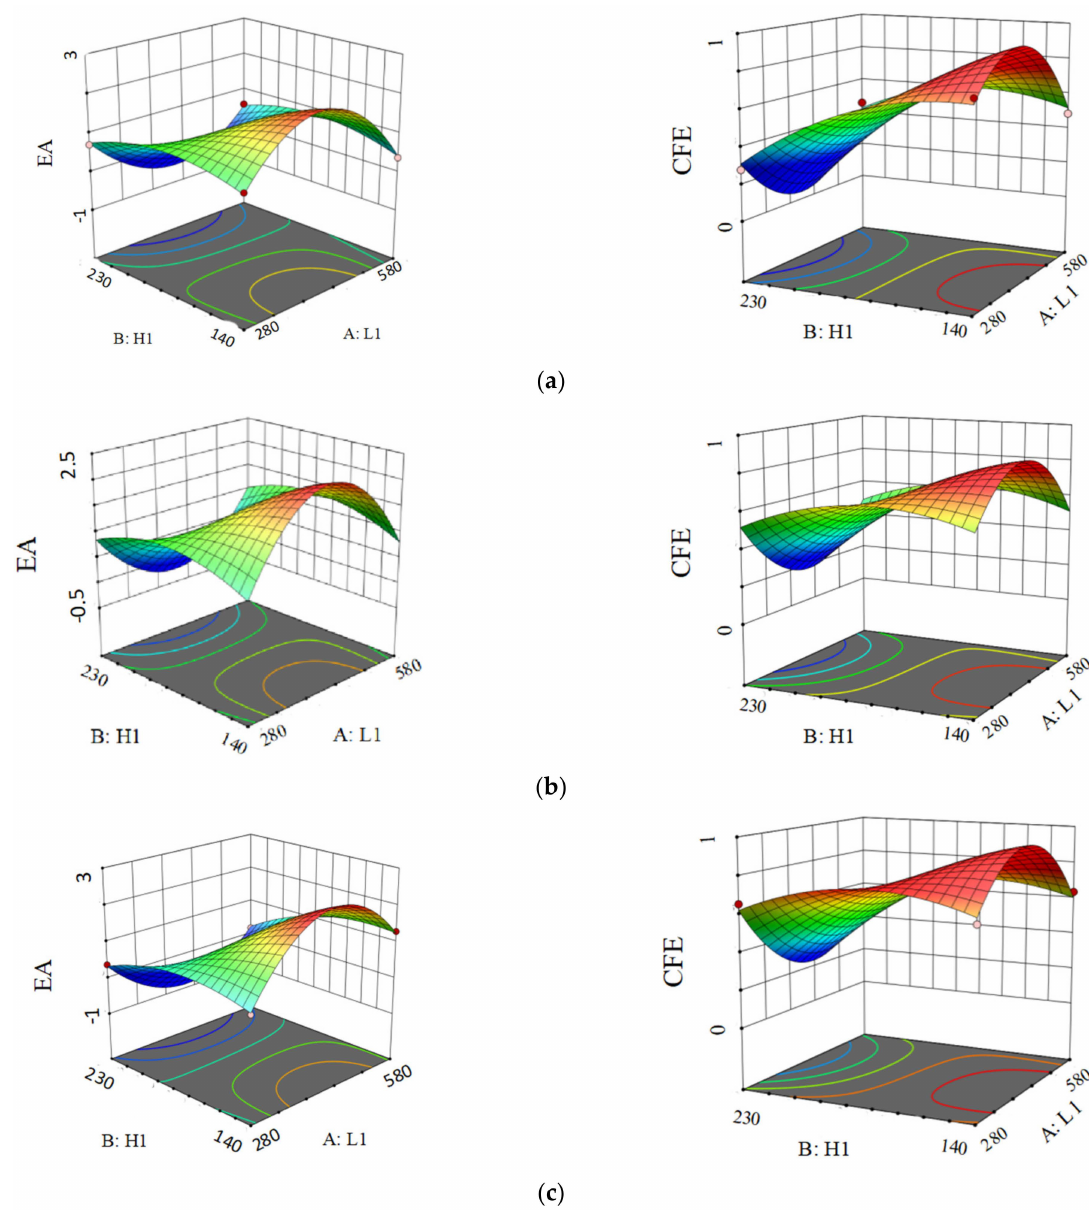
Figure 9. Energy absorption and CFE response surfaces under different configuration